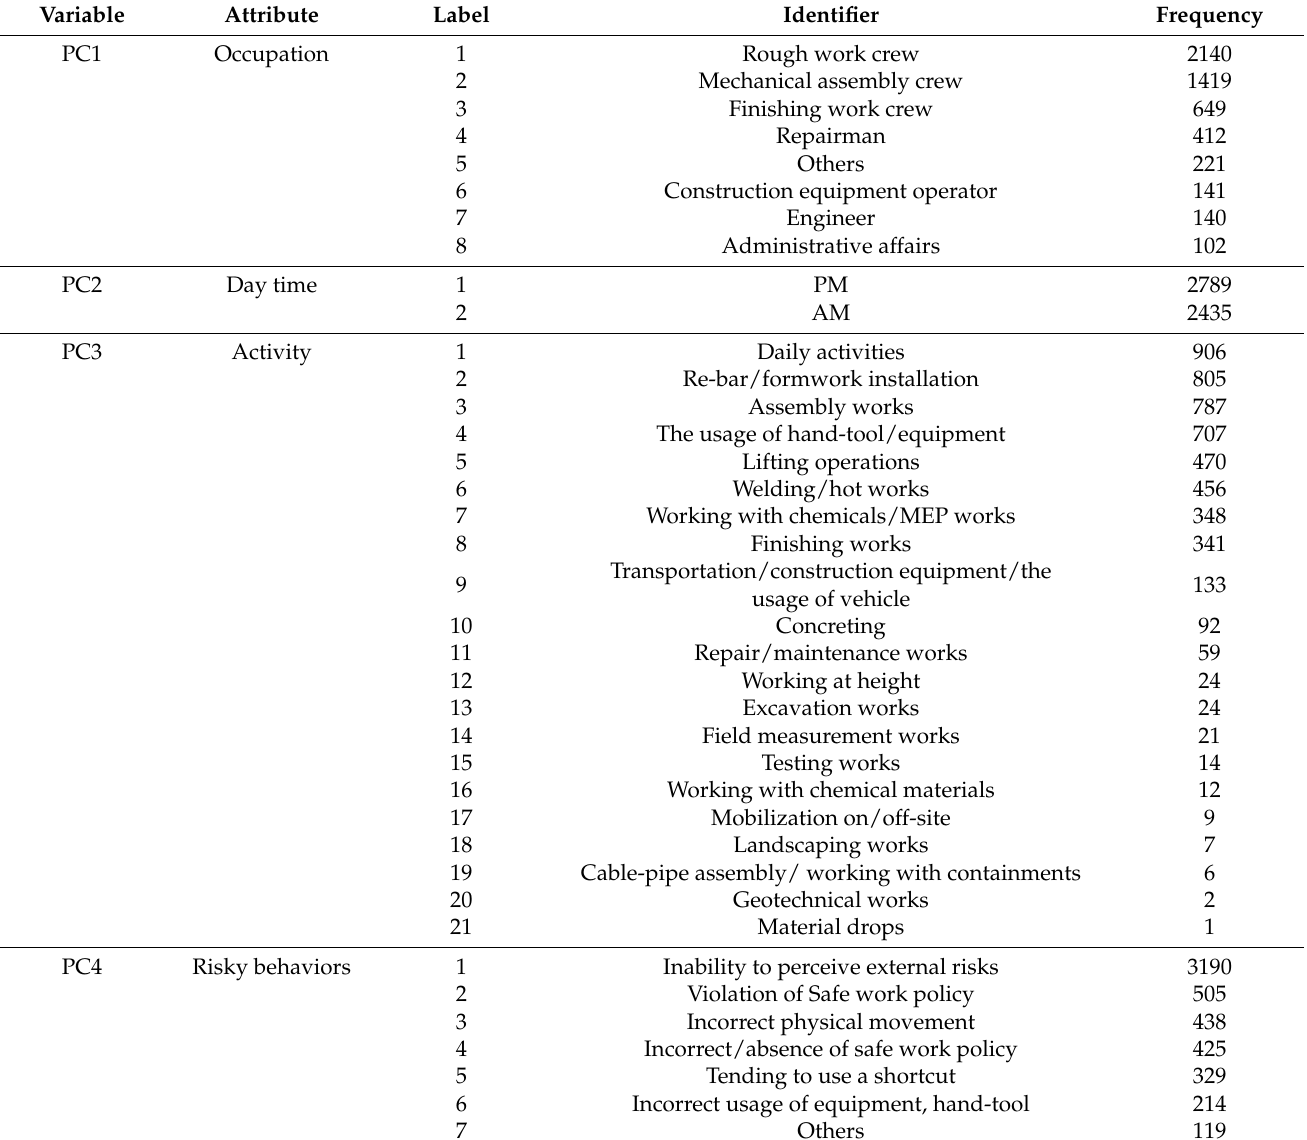
Table 3. Description of the construction accident